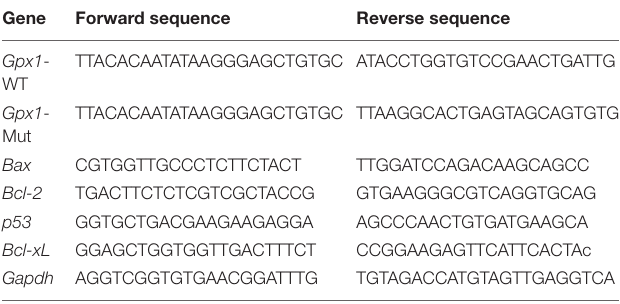
TABLE 1 | PCR primer sequences used in the experiments. Gene Forward